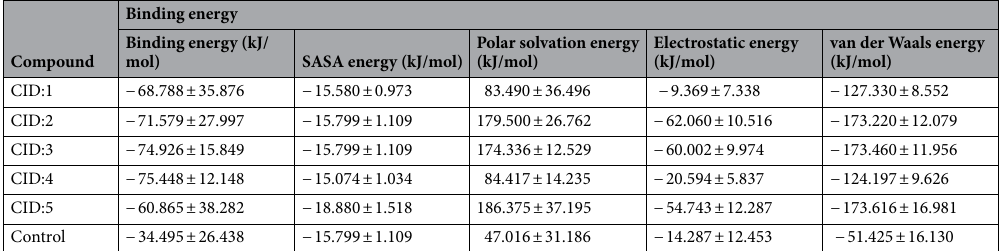
Table 3. Average binding energies of the ligand–protein interactions calculated using the g_mmpbsa tool by extracting 500 snapshots from the MD simulation trajectories.